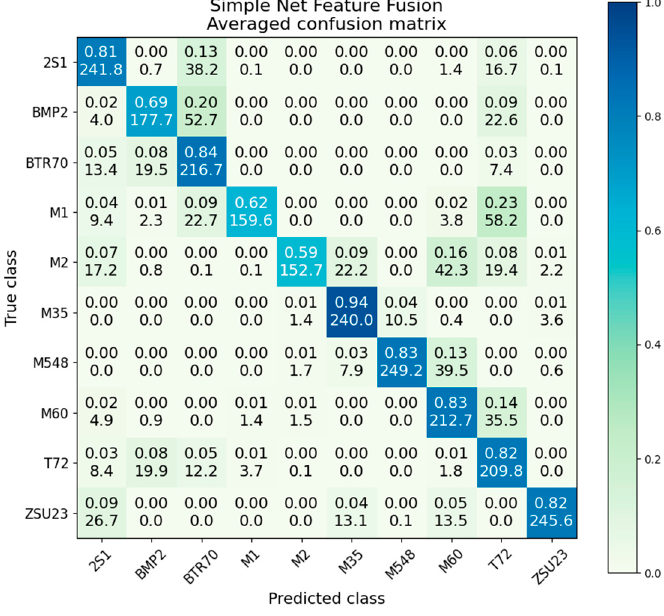
Table 8. Simple net feature fusion intraclass variance (Var) and standard deviation (SD).